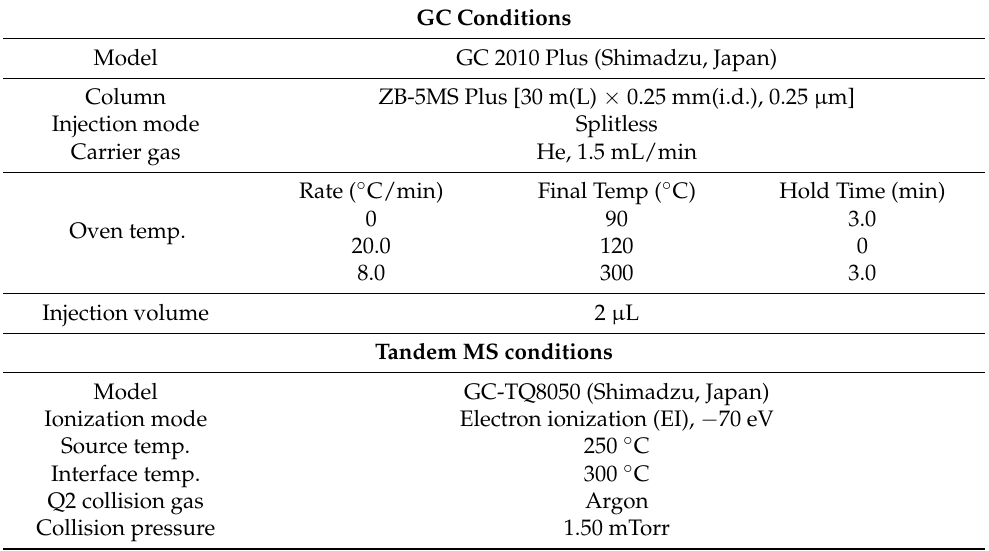
Table A2. Analytical conditions for residue analysis using